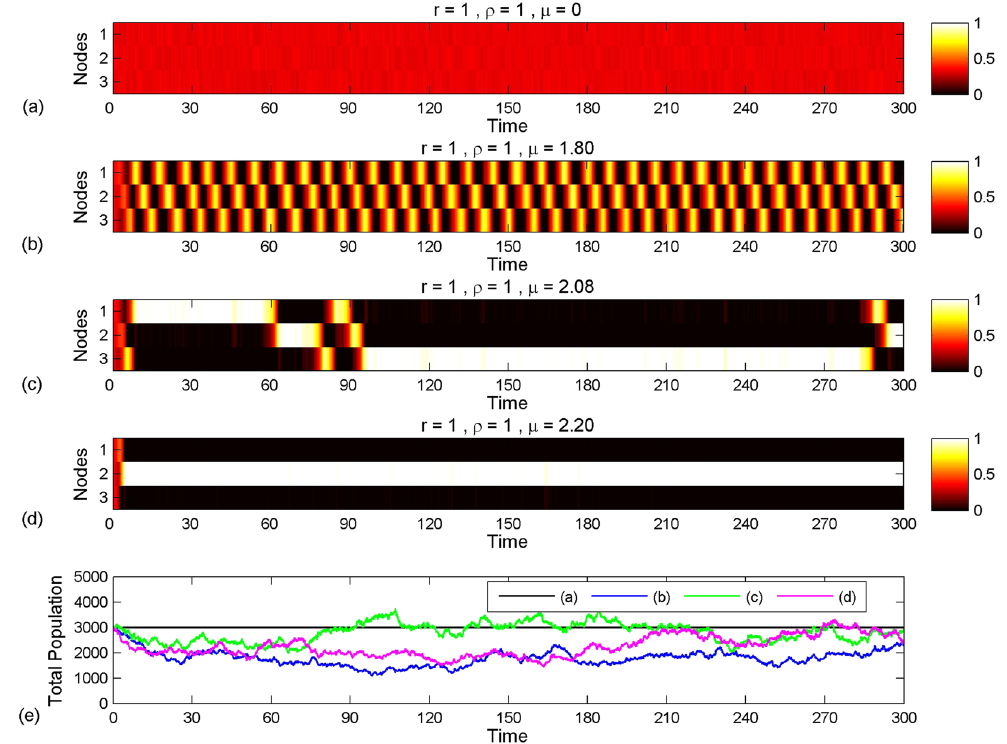
Figure 2. Heat plot of simulated data for four different values of the birth rate μ with common migration rate r = 1, preference ρ = 1. Each simulation initiated with a population of 1000 particles at each node. Colour intensities in the rows correspond to the proportion of particles at each of the three nodes with the scales being given on the right. ( a ) Amorphous-state, μ = 0. ( b ) Wave-state, μ = 1.8 ( θ = 0.6). ( c ) Intermittent-state, μ = 2.08 ( θ = 1.16). ( d ) Collapsed-state, μ = 2.2 ( θ = 1.4). The control parameter θ = (2 μ − 3 r )/ r ρ is discussed in the analysis. ( e ) Total populations in each of the four